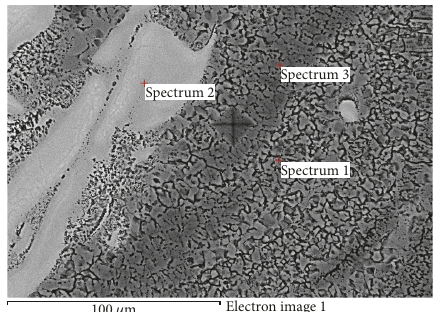
Figure 23: Indentation present in Al-Ti weld metal (sample 4).